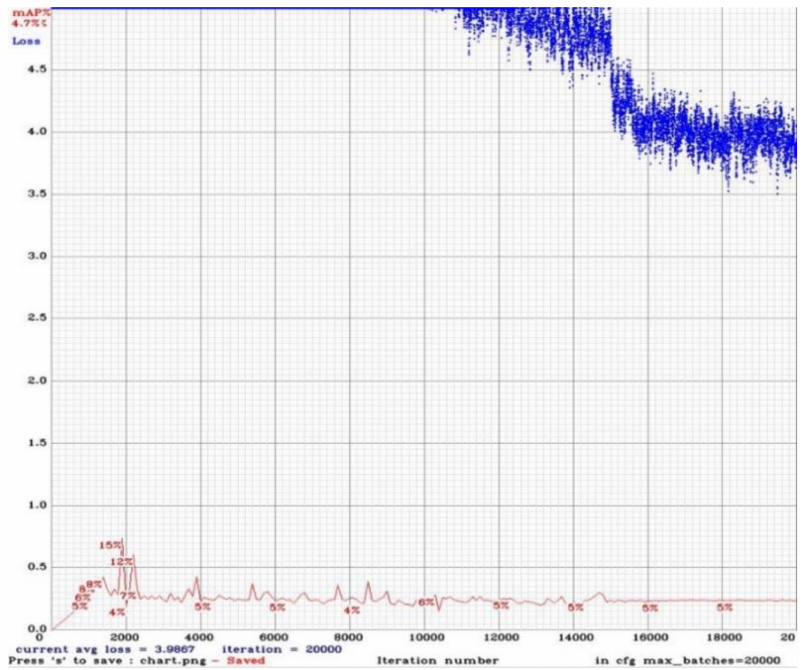
Figure 8. Map and loss scores over each training iteration from YOLOv3 network training on Image Set